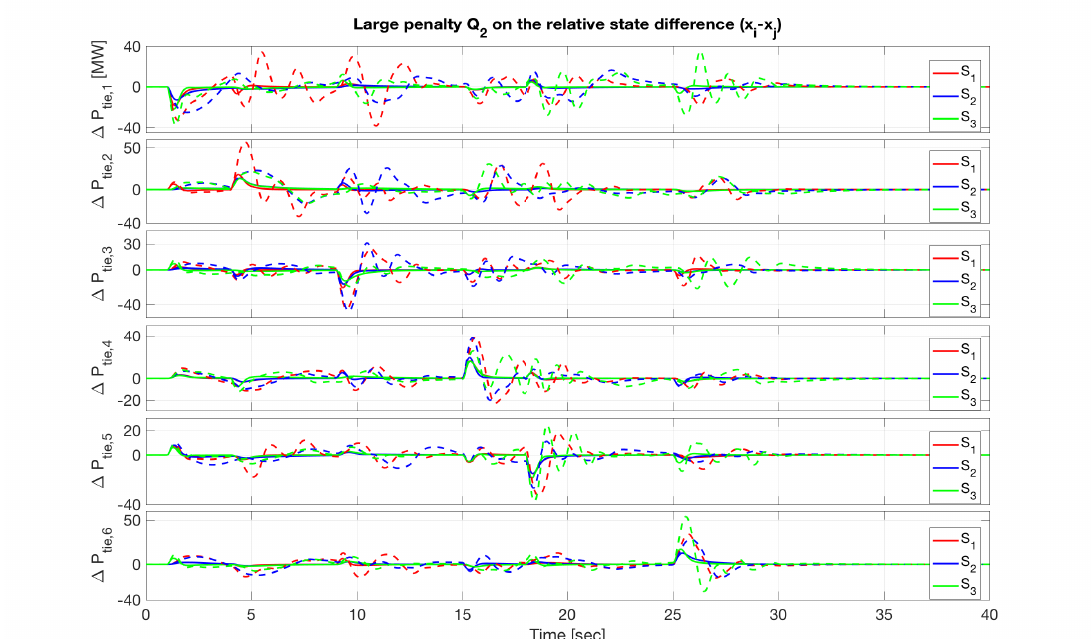
Figure 12. Total power inflow response of the six-area power system for three tie-line interconnection schemes ( S 1 , S 2 , S 3 ) . Large penalty on relative state-difference between interconnected areas. Solid lines depict transients of the linear model; dashed lines depict transients of the model with saturator (Figure